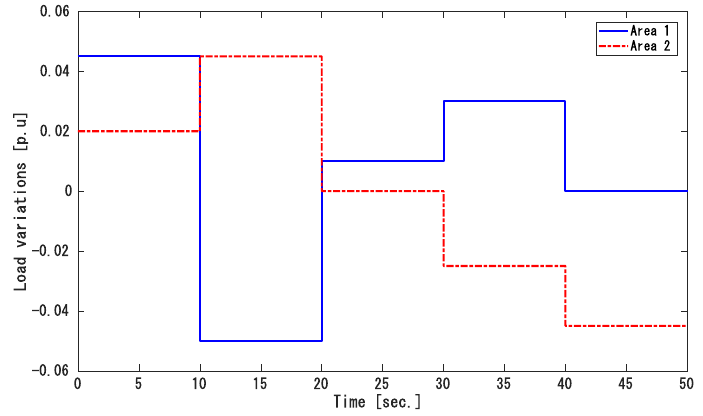
Figure 8. Random load variation.